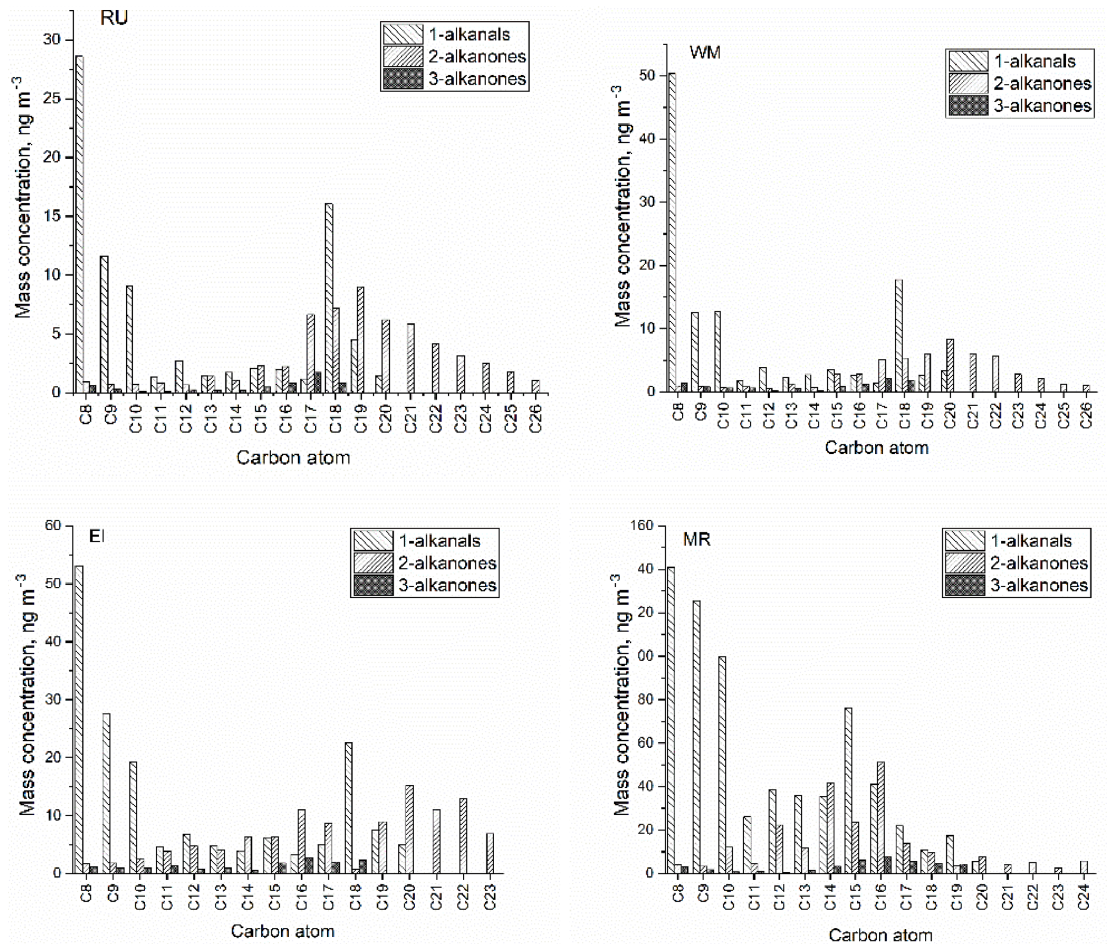
Figure 4. The molecular distribution of particle-bound carbonyl compounds at four sites (RU, WM, EL, and